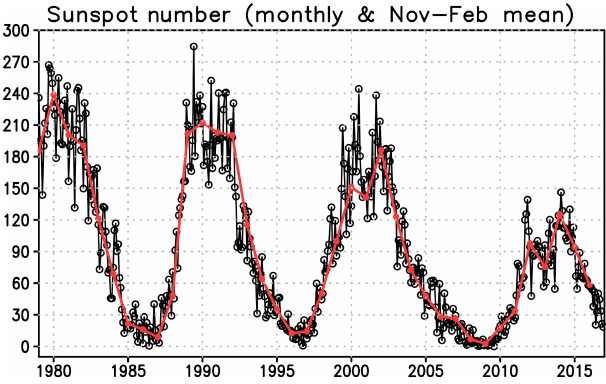
Figure A2. Monthly mean sunspot number (black with open circle) and November–February mean (red with closed circle).